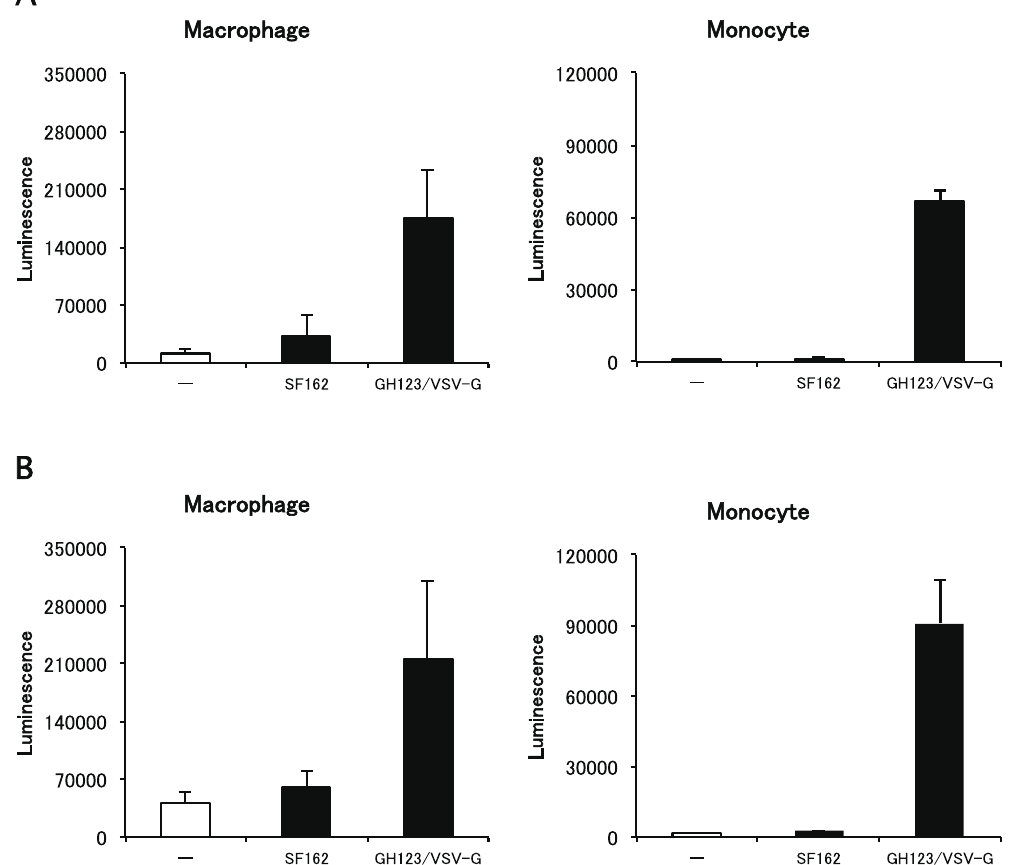
Figure 1. Effects of macrophage-tropic HIV-1 strain and VSV-G-pseudotyped HIV-2 particles on lentivirus vector infection. Monocytes were differentiated into macrophages for 11 days in the presence of GM-CSF. Macrophages or monocytes were treated with macrophage- tropic HIV-1 strain (SF162) or VSV-G pseudotyped and Env-defective HIV-2 particles (GH123/VSV-G) and then infected with lentivirus vector NL43- Luci/VSV-G. Luciferase activity was measured 4 days after infection. Data are plotted as the mean 6 SD of triplicate samples; presented data are representative of three independent experiments using two donors. A: Results of samples obtained from a donor 1. B: Results of samples obtained from a donor